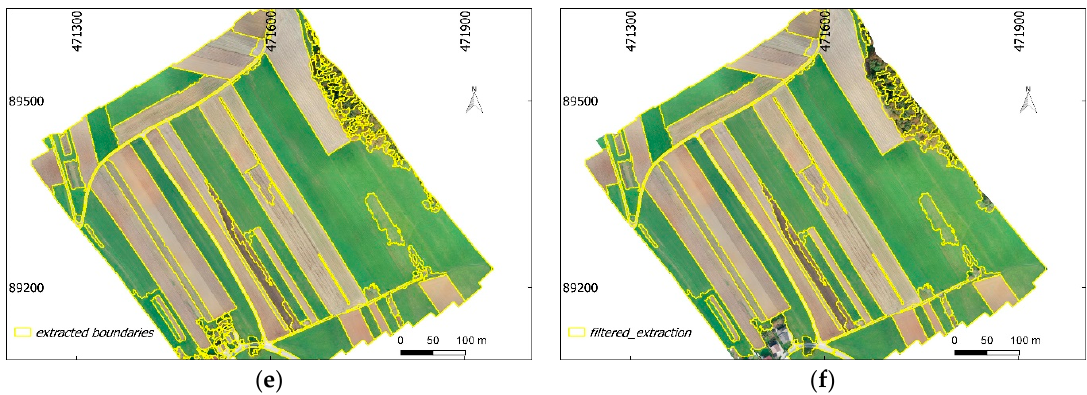
Figure 7. ( a , c , e ) Extracted objects at scale level 80 and merge level 95 for ( a ) GSD 25 cm, ( c ) GSD 50 cm, and ( e ) GSD 100 cm. ( b , d , f ) Filtered objects of scale level 80 and merge level 95 based on minimum object area from the reference data.